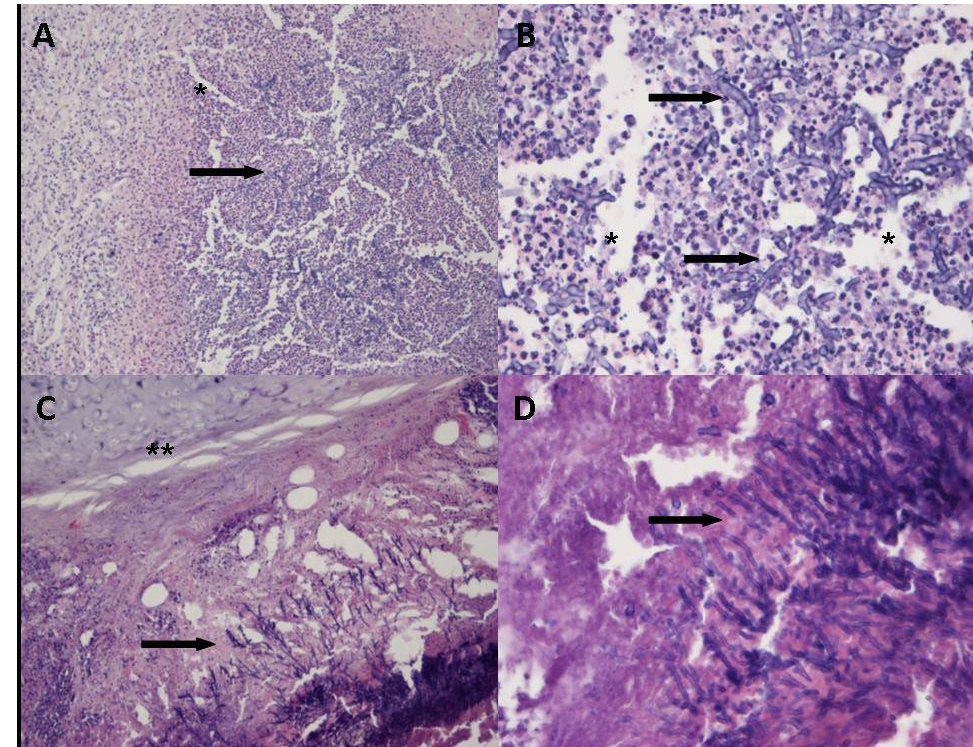
Figure 2. Hematoxylin and eosin-stained sections from large necrotic area of the lung with exuda- tive inflammatory and necrotic lesions (Panels A and B , *) and acute inflammation and necrosis of the bronchial wall (panels C and D , **); numerous typical fungal hyphae of Aspergillus are present (black arrows). OM panels ( A ) and ( C ) 10×, panels ( B ) and ( D ) 40×. arrows). OM panels ( A ) and ( C ) 10 × , panels ( B ) and ( D ) 40 × Among the proven CAPA cases, two patients died despite voriconazole treatment